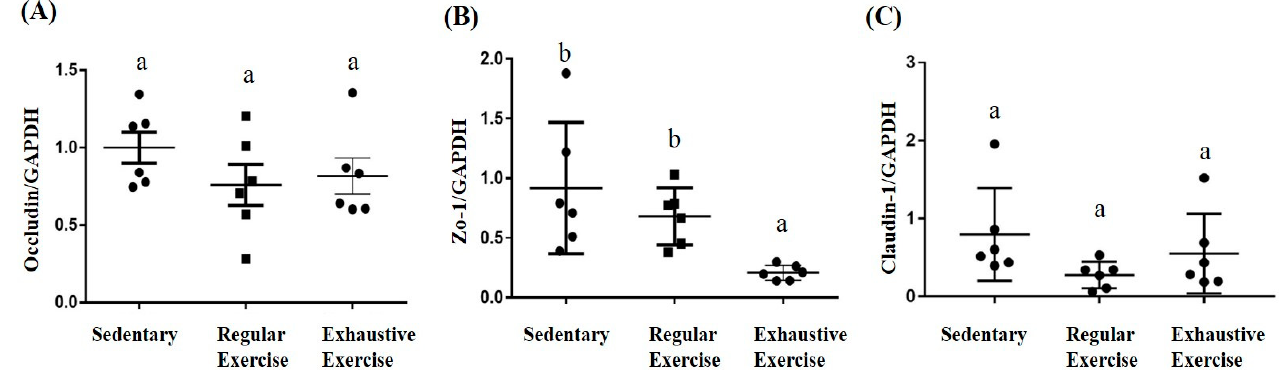
Figure 8. Effects of the eight-week training intervention on tight junction proteins in the proximal colon. Relative expression of Occludin ( A ), ZO-1 ( B ), and Claudin-1 ( C ) were analyzed using quantitative polymerase chain reaction and normalized by GAPDH. Data are represented as mean ± standard deviation, and columns with different letters (a, b) represent significant difference between groups ( p < 0.05) by using one-way ANOVA.